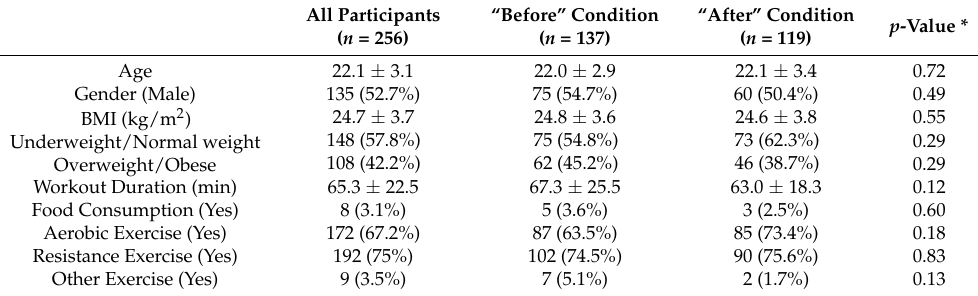
Table 1. Characteristics of the study sample.